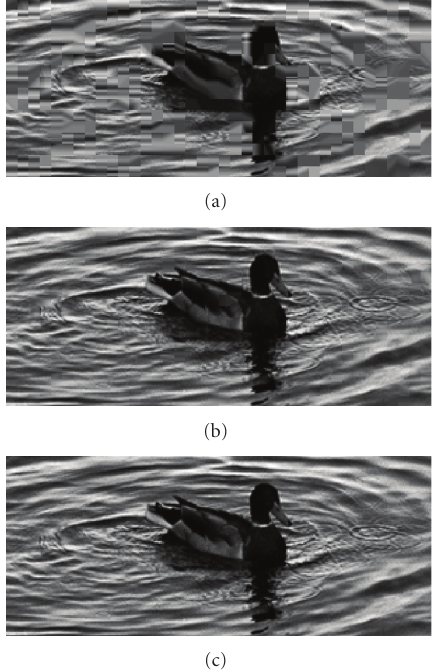
Figure 11: Detail of the ROI area for the Ducks take o ff sequence with di ff erent Δ QP : 0 (a), 15 (b), and 30